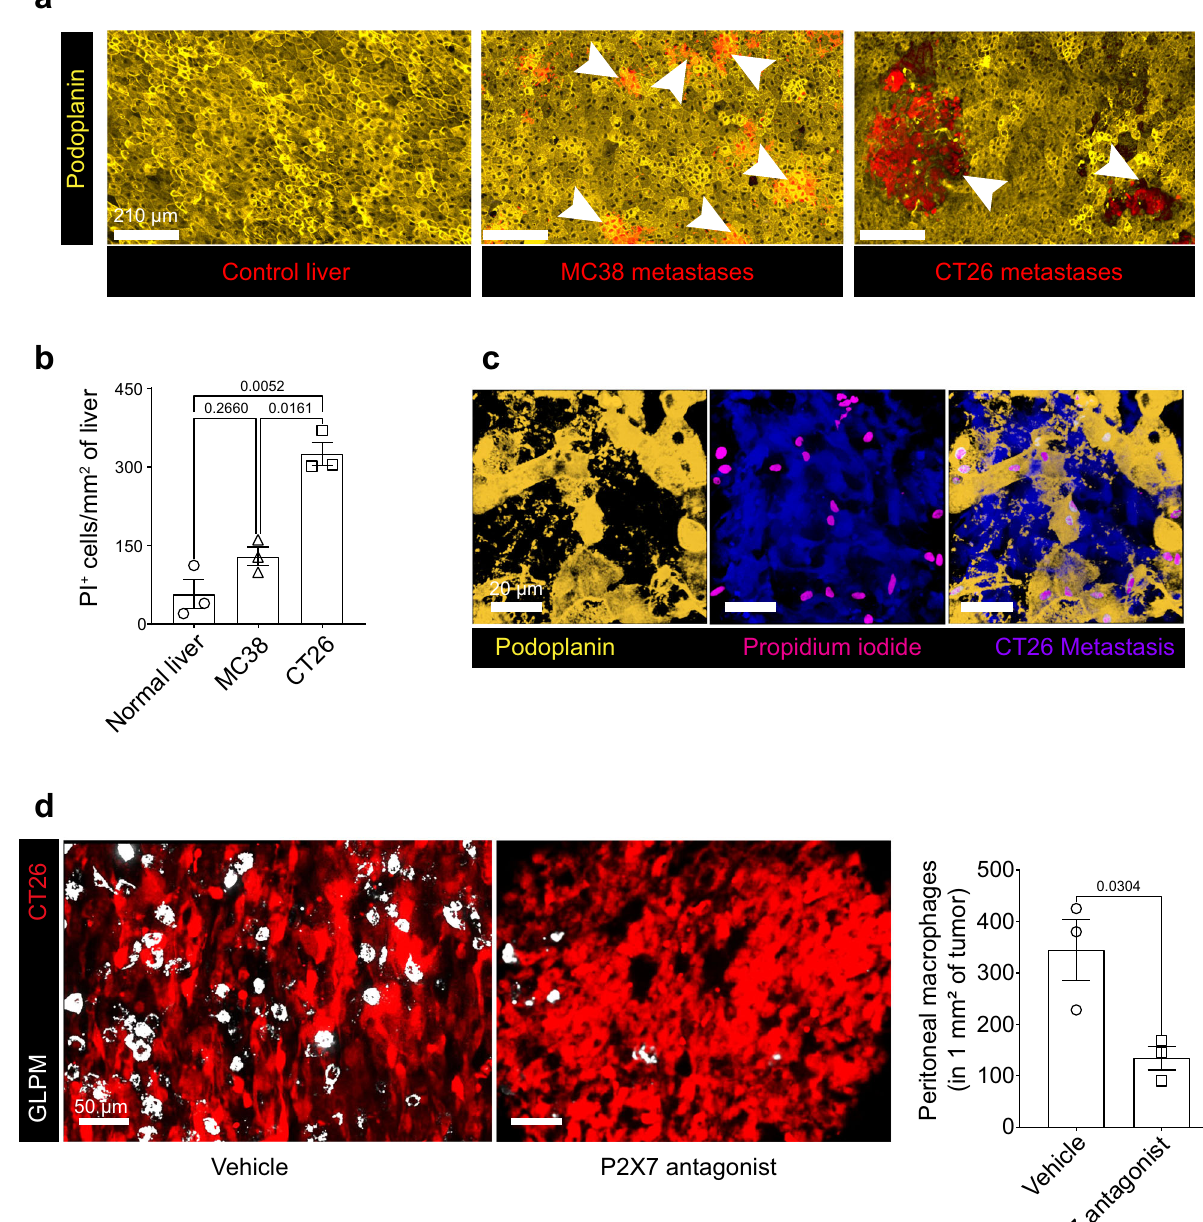
Fig. 3 | Mesothelium damage is required for GLPM recruitment to liver metastases.a Representativeintravitalimagesofthelivermesothelium(yellow)in control, MC38 or CT26 metastases (red; white arrows) (scale bar = 210 μ m) ( n =5 per group; from two independent experiments). b Quanti fi cation of PI + cells from normal,MC38 or CT26 liver ( n =3 mice per group; from one experiment), P values werecalculatedusingordinarytwo-wayANOVAwithTukey ’ smultiplecomparisons test, P =0.2660 normal liver vs MC38, P =0.0052 normal liver vs CT26, P =0.0161 MC38 vs CT26. c Representative image of colocalization of podoplanin + (yellow)